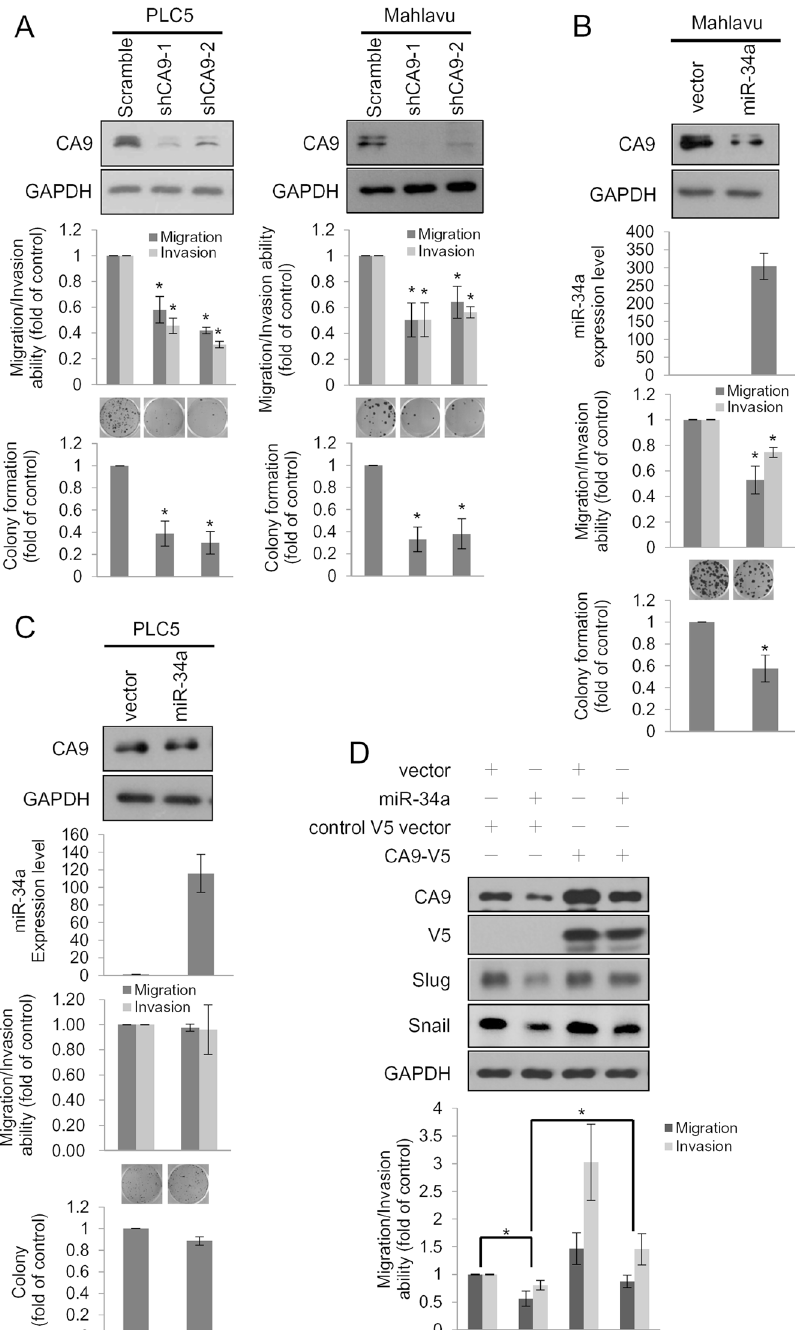
Figure 3. The miR-34a/CA9 axis regulates cell proliferation and mobility of hepatocellular carcinoma (HCC). ( A ) Migration, invasion, and colony formation assays were conducted after infection with a lentivirus carrying CA9 shRNAs or scrambled shRNA in PLC5 and Mahlavu cells. Upper panels: Western blot analysis of CA9. Middle panels: Migration/invasion abilities of CA9 knockdown cells. Lower panel: Colony formation abilities of CA9 knockdown cells. Representative micrographs of colony formation assays shown above the plot. ( B , C ) Migration, invasion, and colony formation assays were conducted after transfection of miR-34a or a control plasmid in Mahlavu and PLC5 cells. miR-34a and CA9 expression levels were examined by Western blotting and a real-time PCR, respectively, as shown in the upper two panels. Middle panels: Migration/invasion abilities of miR-34a-overexpressing cells. Lower panel: Colony formation abilities of miR-34a-overexpressing cells. Representative micrographs of colony formation assays shown above the plot. ( D ) Control and miR-34a- overexpressing Mahlavu cells were infected with lentiviruses carrying either control or CA9-V5 for 48 h and subjected to transwell migration and invasion assays. Migrated/invaded cells are presented as multiples of the control. Three independent replicates were performed for each experiment. Error bars, ± S.D. * p < 0.05 by two- sided Student’s t